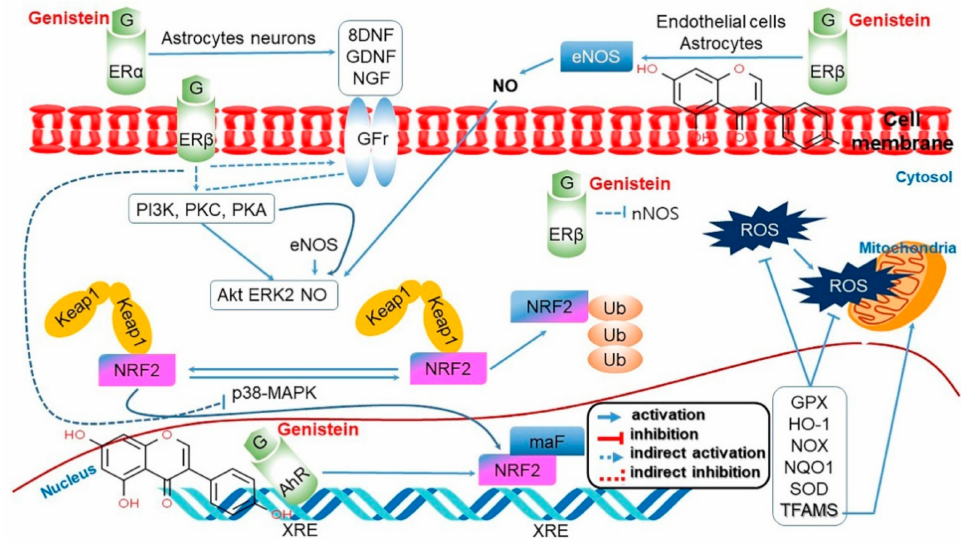
Figure 7. Antioxidant pathways activated by genistein (G) in cerebral ischemia to detoxify reactive oxygen species (ROS). Phosphorylation of nuclear factor erythroid 2 (Nrf2)-related substrate adapter protein Keap1 leads to either ubiquitination (Ub) and degradation of Nrf2 or release of Nrf2 for translocation to the nucleus, association with small musculoaponeurotic fibrosarcoma (Maf) protein, and activation of the transcription of several antioxidant genes (GPX, HO-1, NOX, NQQ1, and SOD) and Tfam through binding the antioxidant response element. The kinase pathways promoting this ac- tion (PI3K/Akt, PKC/ERK, and PKA/eNOS/NO) are stimulated by ER β and its interaction with GFr through several intermediate proteins. This action mode is further processed by genistein-dependent growth factors from astrocytes and neurons and by the ER β -induced NO generated in endothelial cells and astrocytes. Conversely, genistein inhibits degradation of Nrf2 by inhibiting p38 MAPK through activation of ER β , which plays a role in inhibiting nNOS-induced ROS generation. Finally, genistein can enhance Nrf2-induced transcription by reinforcing AhR binding to the xenobiotic response element (XRE) [127]. Figure adapted from Schreihofer and Oppong-Gyebi